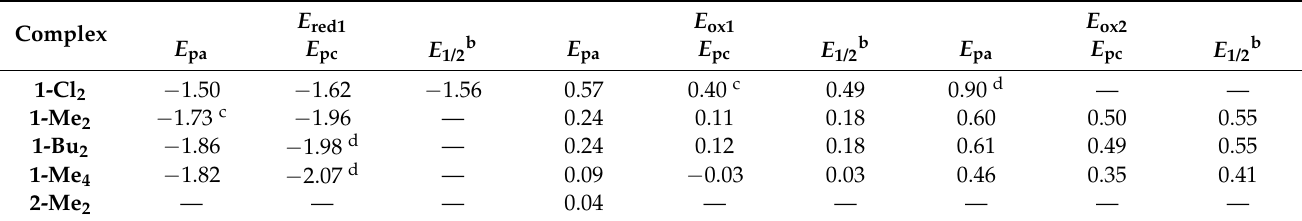
Figure 4. Cyclic voltammograms of the Al III complexes 1 and 2 in a 0.1 M Bu 4 NPF 6 solution of dichloromethane. The scan speed was 100 mV s − 1 . ( a ) The anodic scans in the range of the first oxidation waves; ( b ) The anodic scans in the range of the first and second oxidation waves; ( c ) The cathodic scans in the range of the first reduction waves. Table 2. Redox potentials a (V vs. Fc/Fc + ) for the Al III complexes 1 and 2